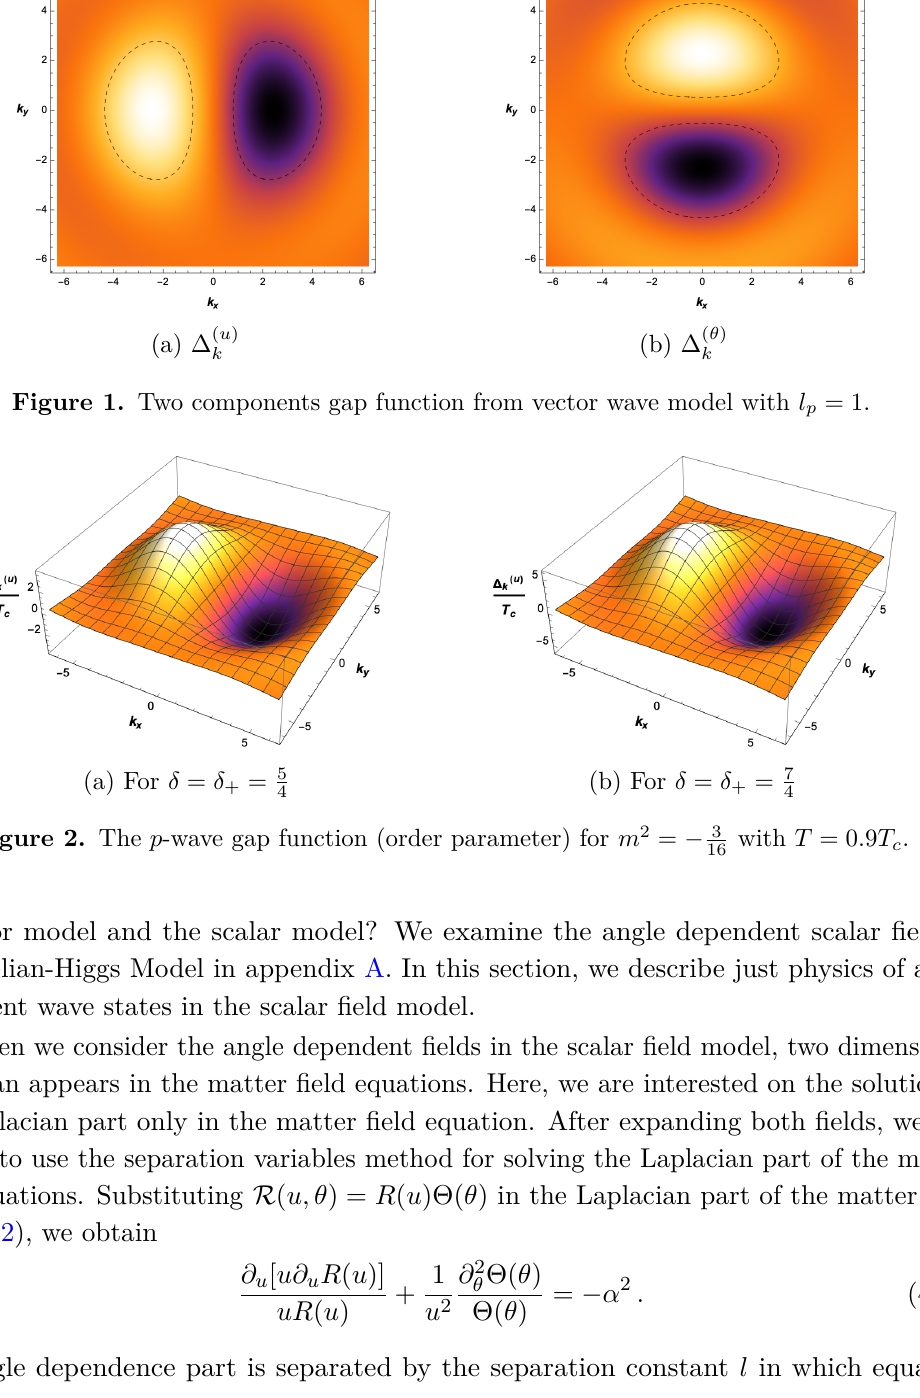
with T = 0 . 9 T c 16